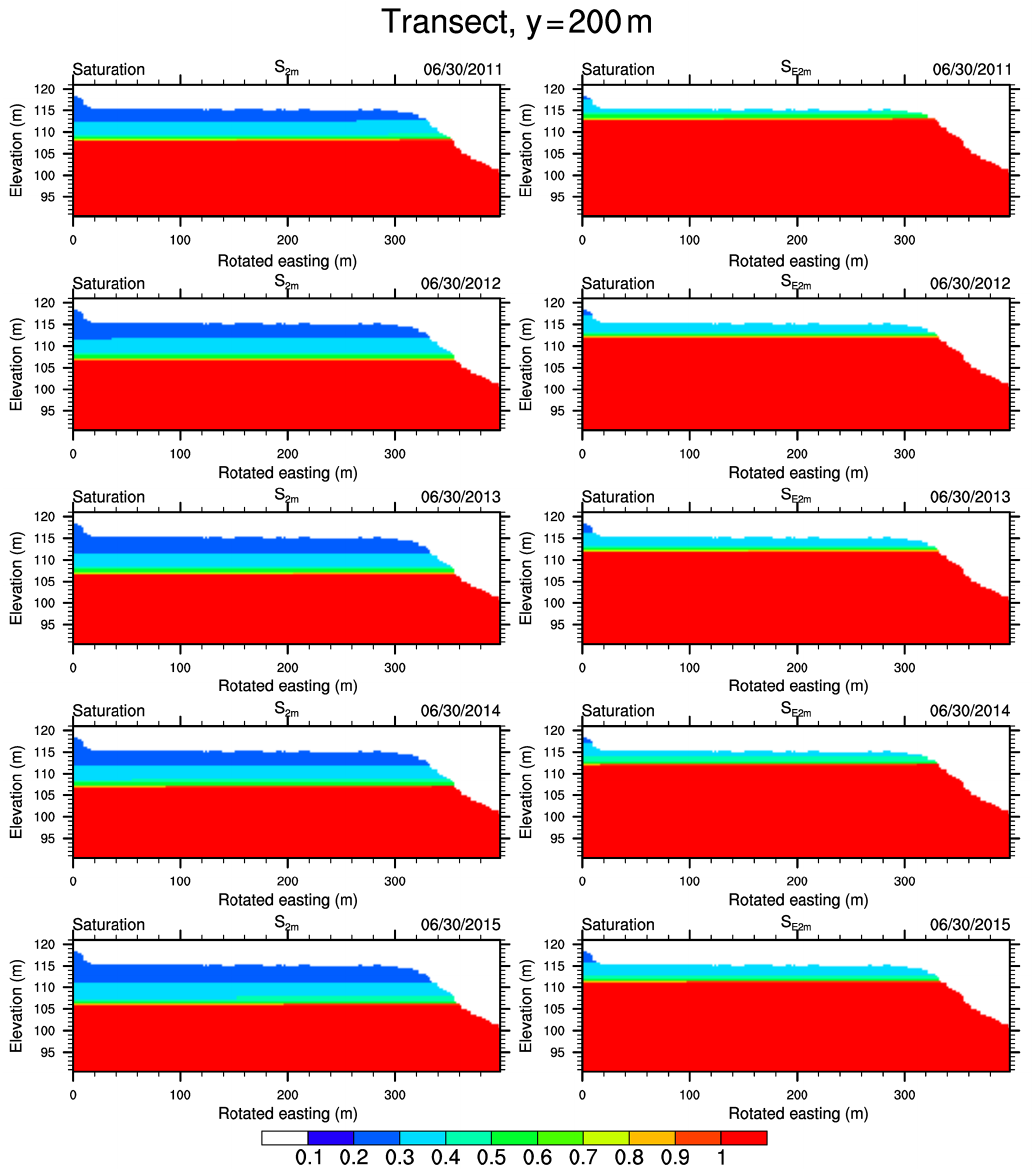
Figure 11. Liquid saturation levels (unitless) across a transect perpendicular to the river ( y = 200m) on 30 June of each year in the study period from (a) S 2m and (b) S E2m